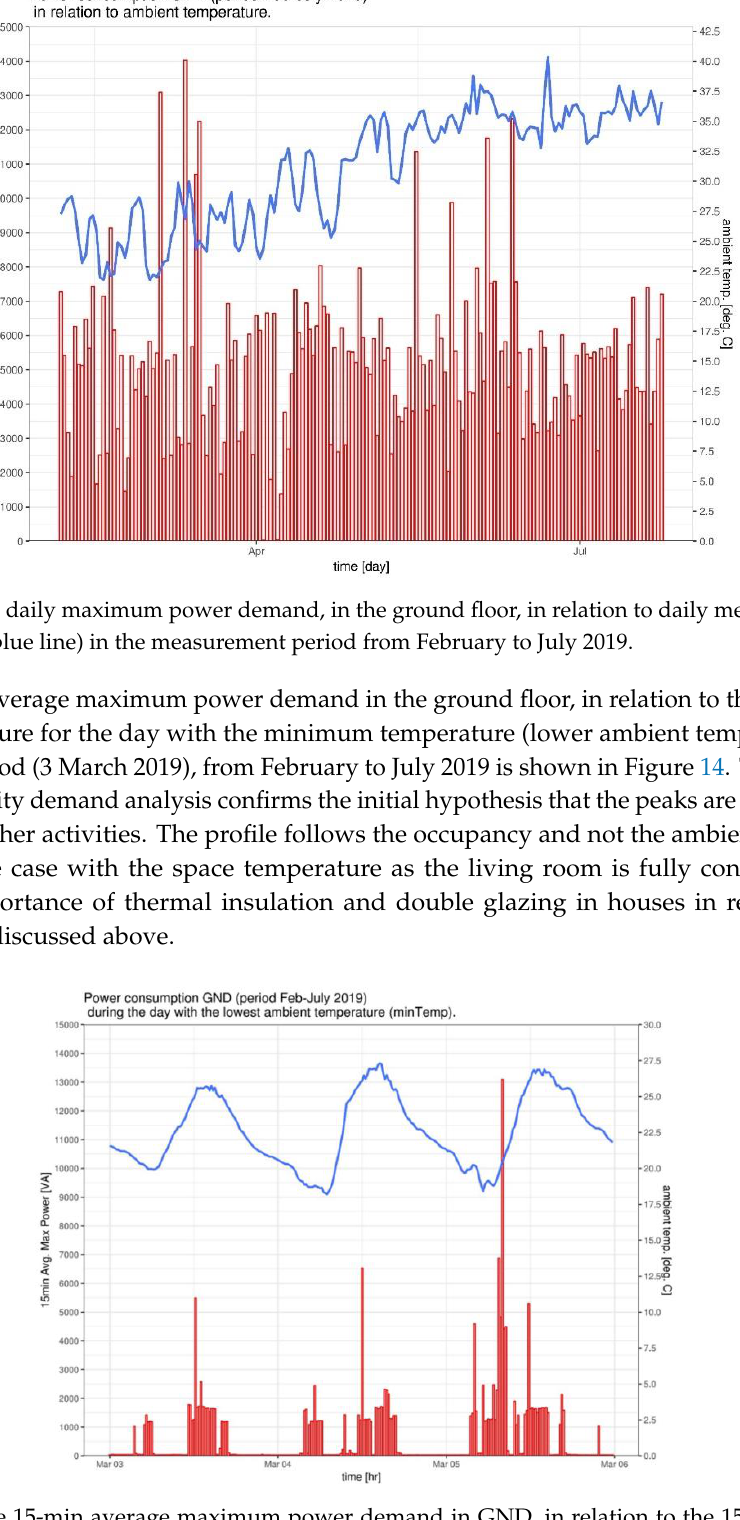
Figure 14. The 15-min average maximum power demand in GND, in relation to the 15-min mean ambient temperature (blue line) for the day with the minimum temperature in the measurement period.